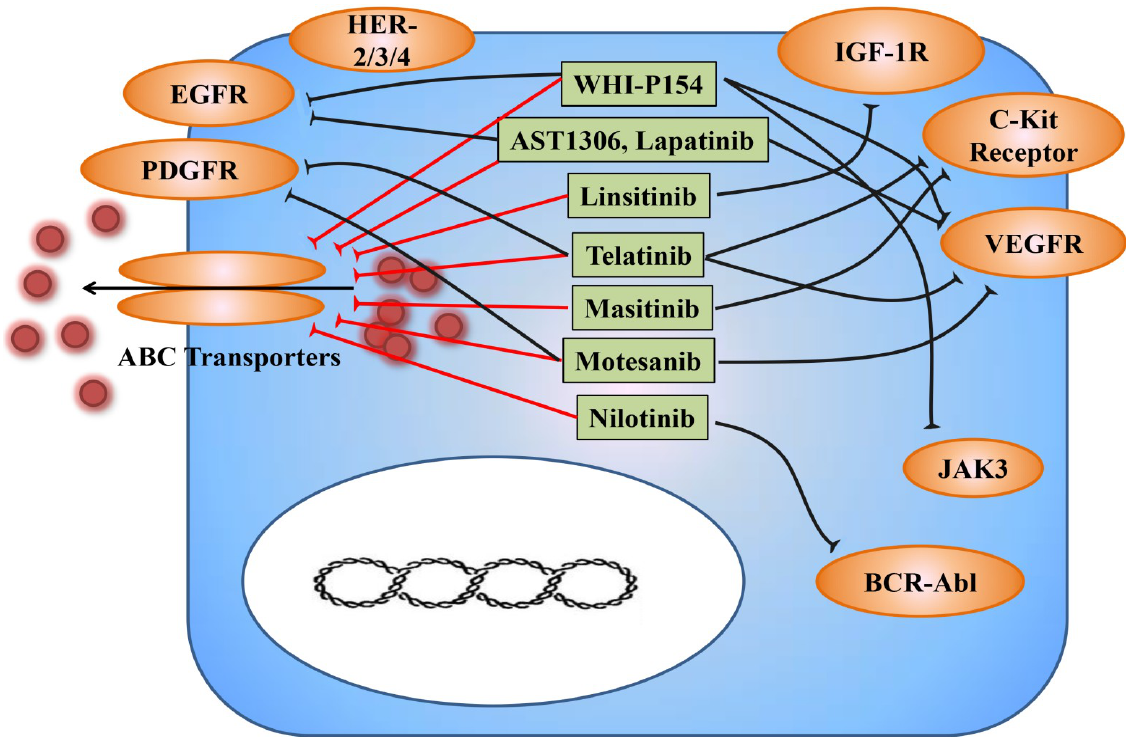
Figure 3. Different types of small-molecule tyrosine kinase inhibitors (TKIs) antagonize MDR mediated by ABC transporters. Overexpression of ABC transporters leads to accelerated efflux of anticancer drugs from cancer cells. Modulation of ABC transporters by different types of TKIs, such as AST1306, lapatinib, linsitinib, masitinib, motesanib, nilotinib, telatinib and WHI-P154, leads to enhanced intracellular accumulation of anticancer drugs. BCR-Abl, breakpoint cluster region-Abelson; JAK3, Janus kinase 3; VEGFR, vascular endothelial growth factor receptor; c-Kit, mast/stem cell growth factor receptor; IGF-1R, insulin-like growth factor 1 receptor; EGFR, epidermal growth factor receptor; PDGFR, platelet-derived growth factor